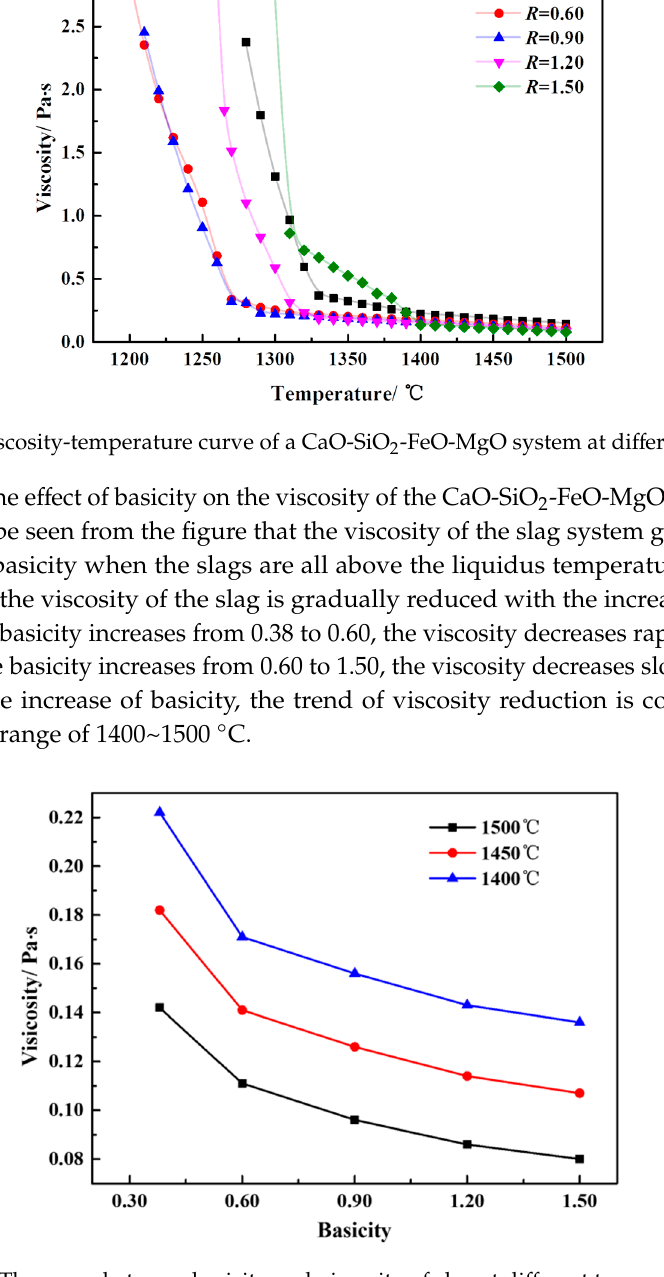
Figure 7. The curve between basicity and viscosity of slag at different temperatures.